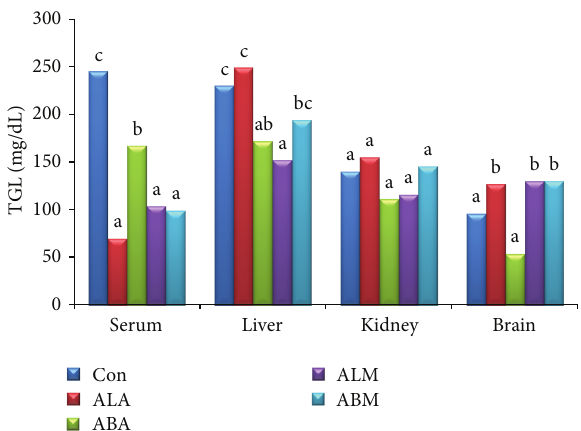
Figure 2: Triglyceride content of control and extract treated groups (mg dL −1 ).